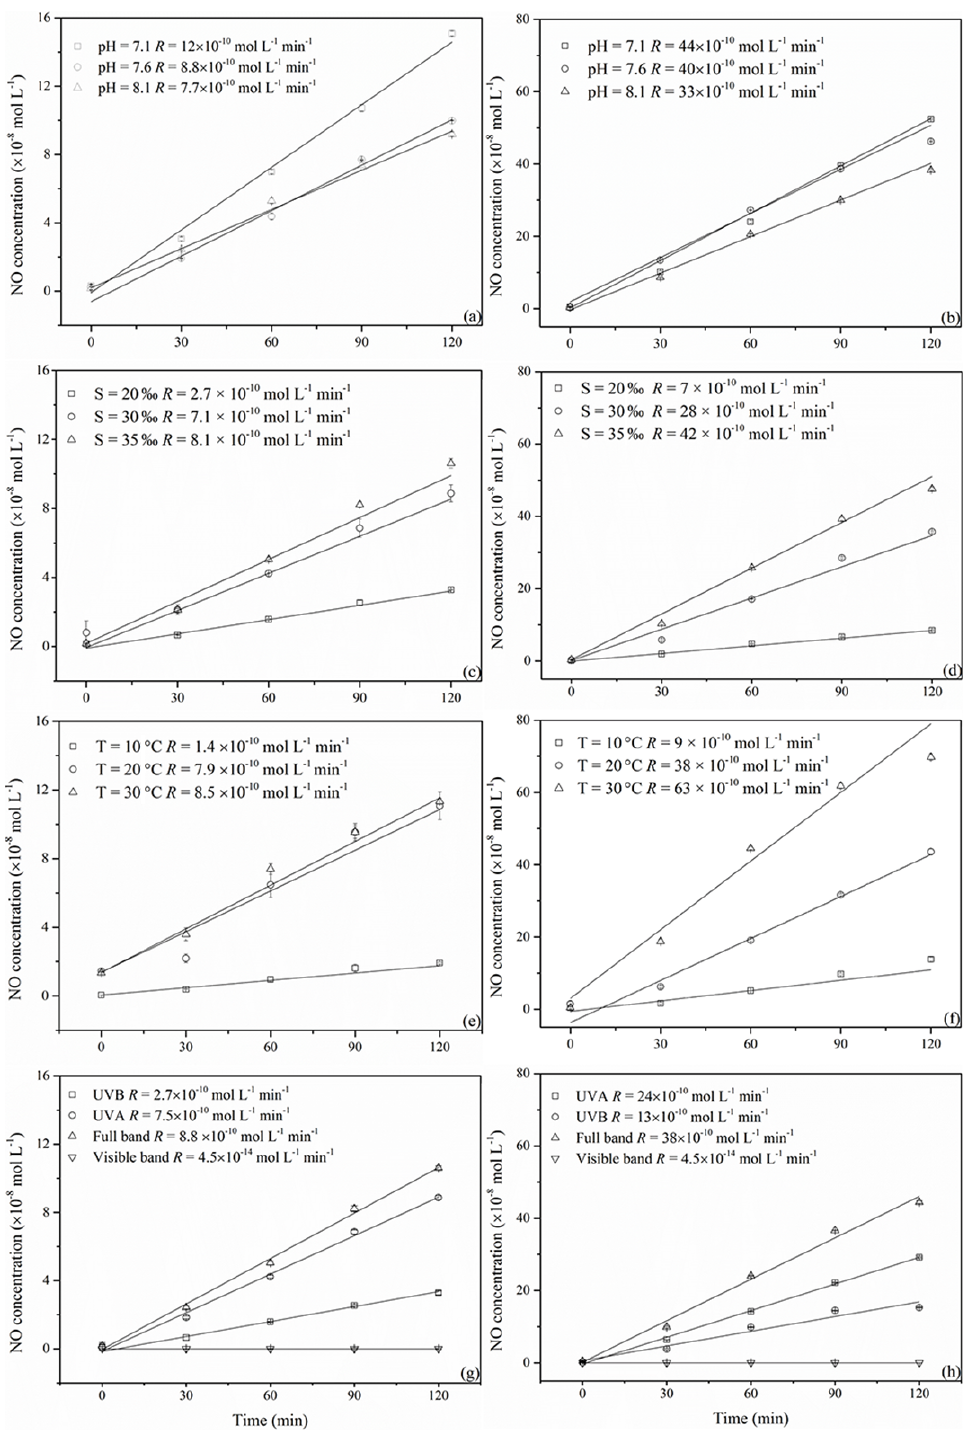
Figure 4. NO concentration changes with irradiation time at different pH, salinity, temperature, and illumination conditions ( a , c , e , and g for 0.5µmolL − 1 NO − and b , d , f , and h for 5.0µmolL − 1 NO − 2 2